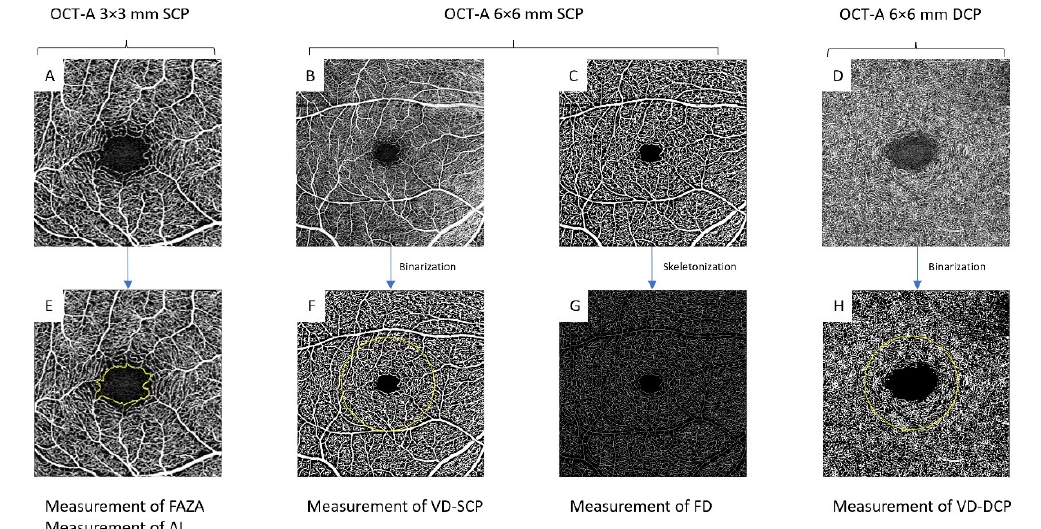
Figure 1. Roll-up summary of the measures performed: ( A ): 3 × 3 mm OCT-A imaging used to measure FAZA and AI ( E ); ( B , C ): 6 × 6-mm OCT-A images of the superficial capillary plexus ( B ) before and ( C ) after binarization to measure ( F ) vessel density and ( G ) fractal dimension after skeletonization; ( D ): 6 × 6-mm OCT-A images of the deep capillary plexus to measure vessel density ( H ) after binarization. FAZA: foveal avascular zone area; FD: fractal dimension; DCP: deep capillary plexus; VD: vessel density; AI: acircularity index; SCP: superficial capillary plexus.